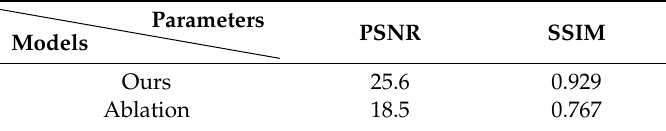
Table 2. Quantitative evaluation results after